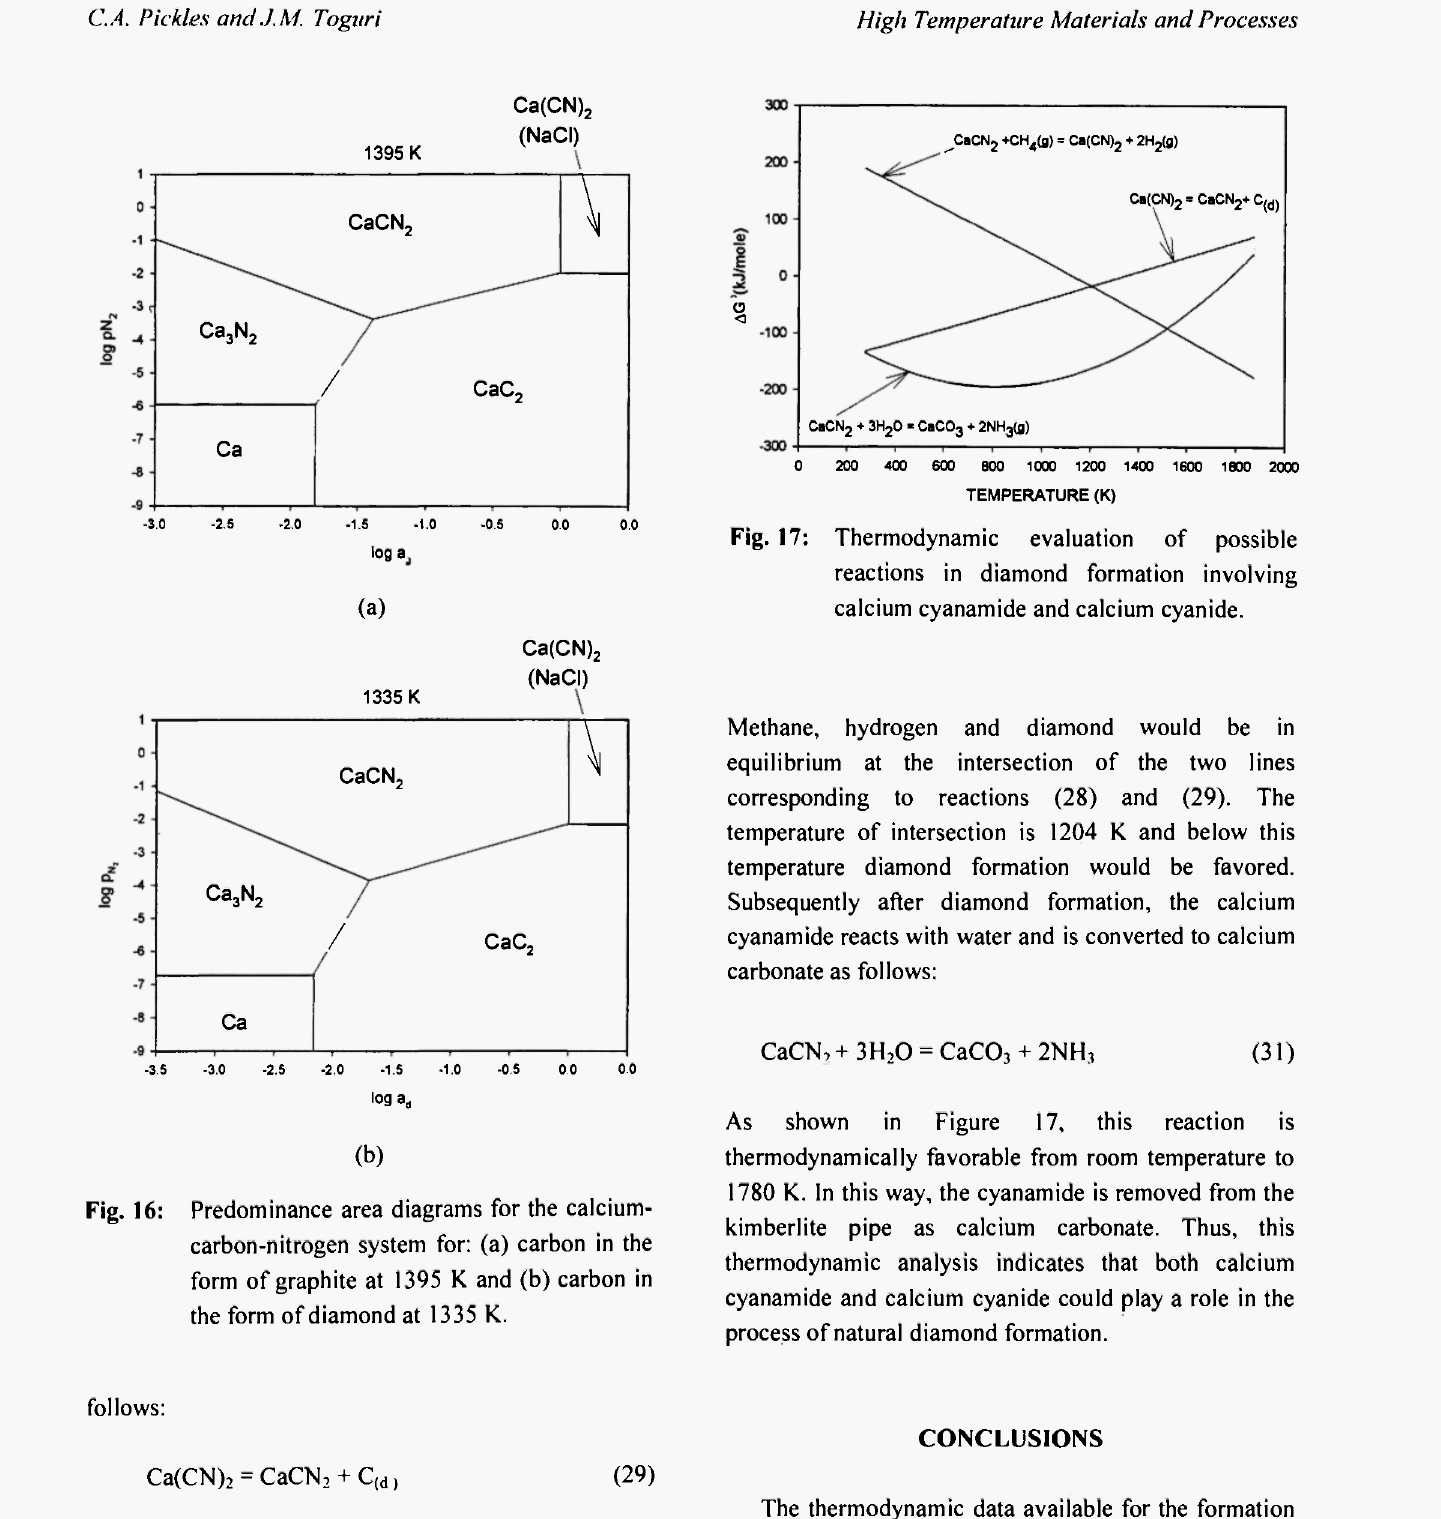
Fig. 16: Predominance area diagrams for the calcium- carbon-nitrogen system for: (a) carbon in the form of graphite at 1395 Κ and (b) carbon in the form of diamond at 1335 K.